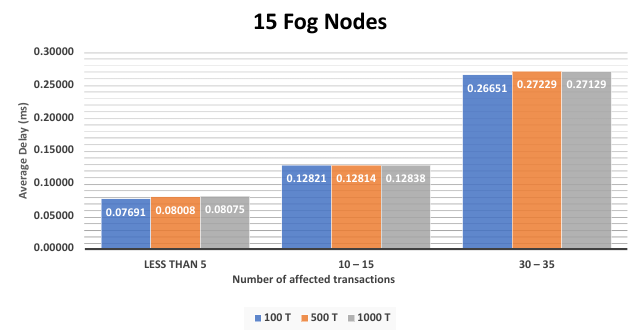
Figure A5. The impact of different number of transactions on 10 fog nodes.